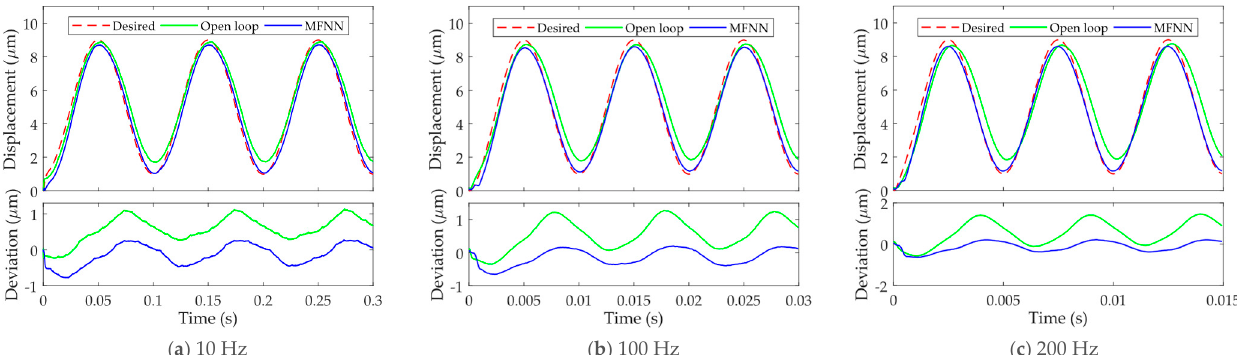
Figure 7. Hysteresis compensation performances of the MFNN based inverse model at different frequencies. ( a ) 10 Hz; ( b ) 100 Hz; ( c ) 200 Hz.